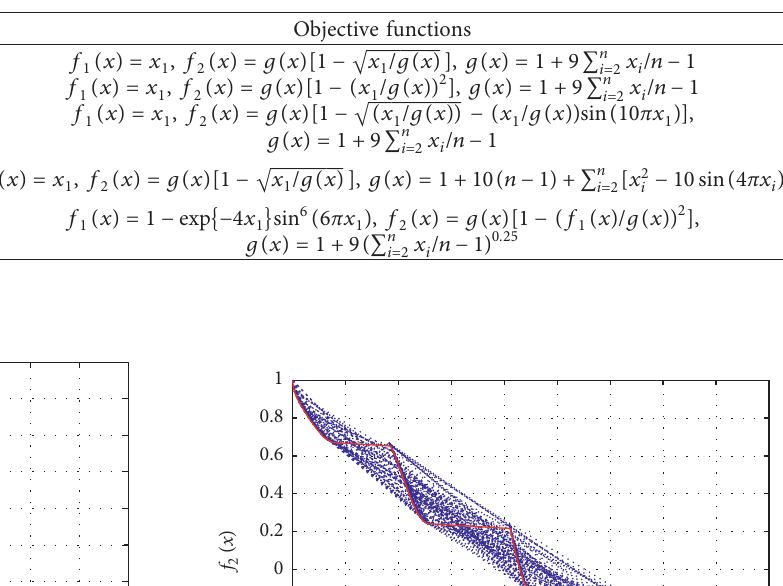
Table 1: Standard test problems.